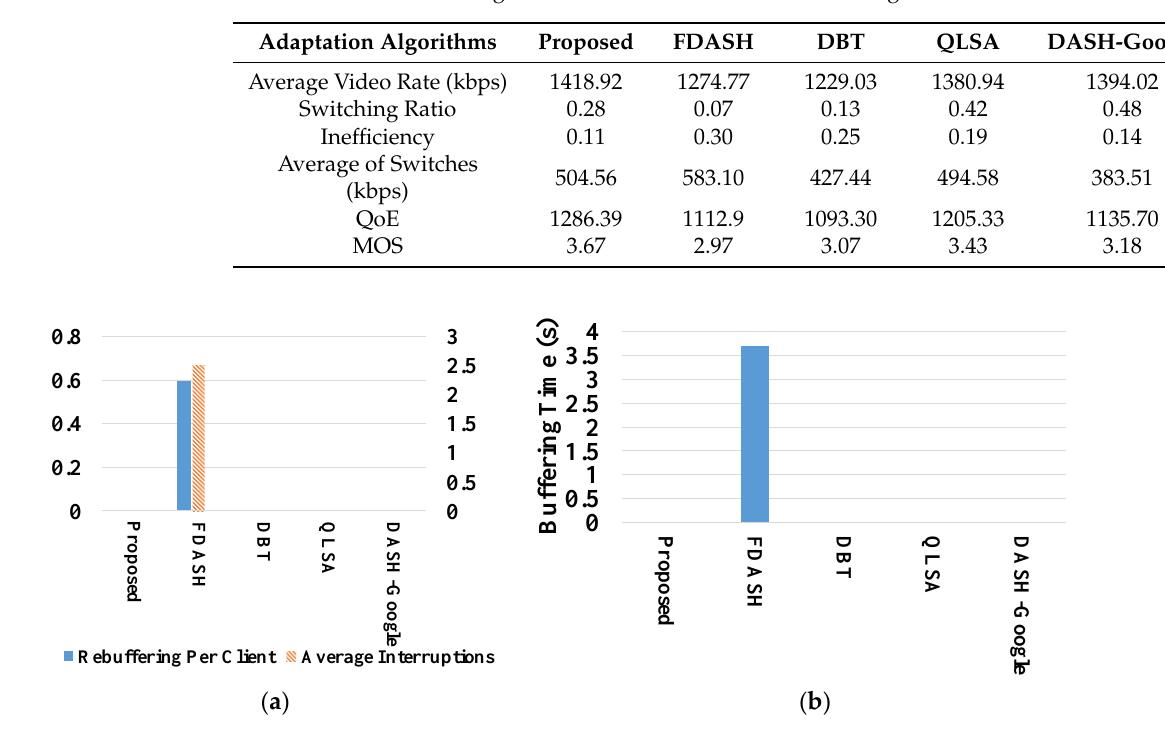
Table 8. Performance of the algorithms at a buffer size of 60 s and a segment duration of 4 s.